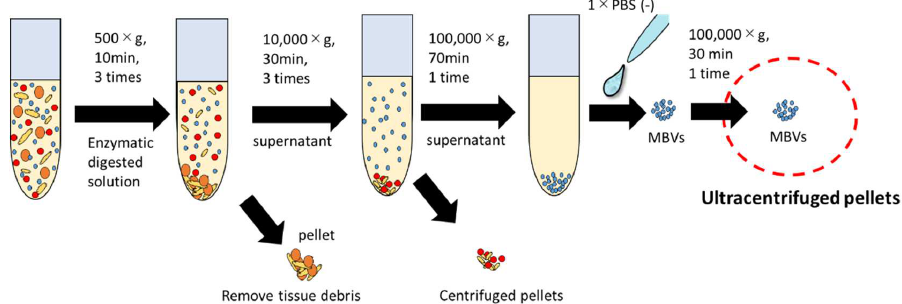
Figure 3. Schematic overview of MBV purification steps.